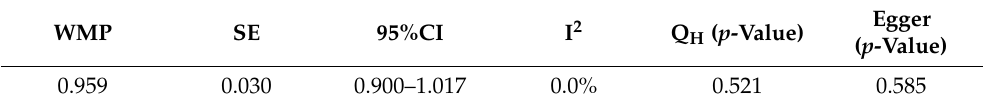
Table 2. Meta-analysis results referring to success rate. Caption: WMP = weighted mean prevalence;